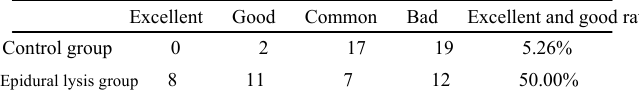
TABLE 3 - Effect standard of Macnab lumbar disease six months after the treatment.